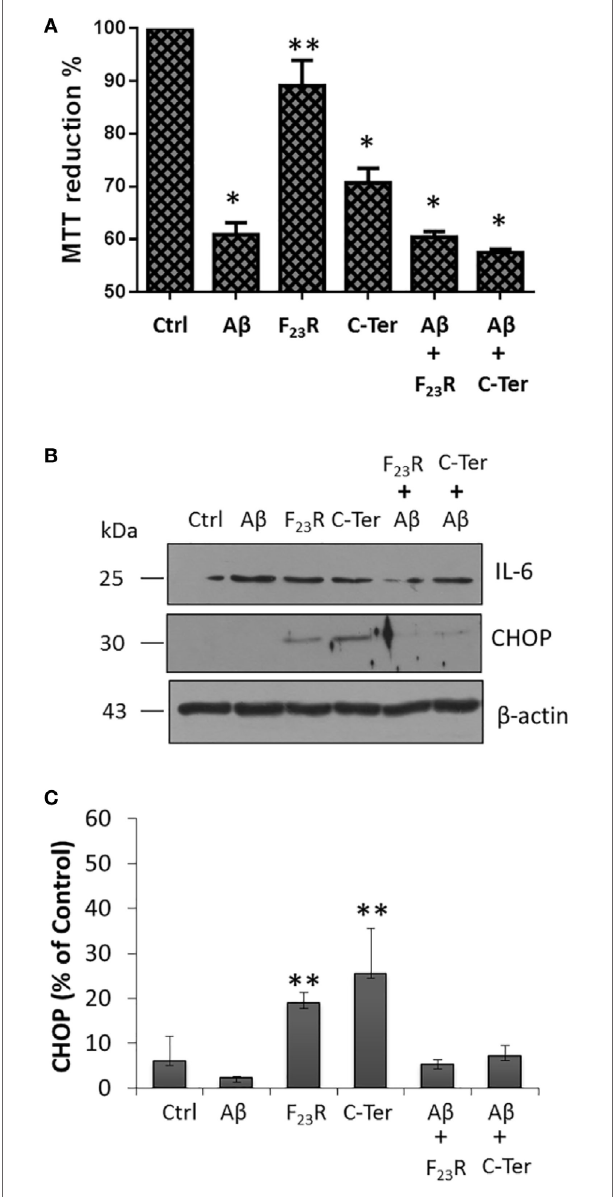
FigUre 7 | Functional modulation of islet amyloid polypeptide sequences in microglia. (a) Responses of cytotoxicity obtained in the microglia model, using the peptide A β as a reference ( n = 6, X ± SD) * p < 0.001, ** p < 0.05. (B) Under the same treatments, CHOP and IL-6 were evaluated, (c) quantification of CHOP expression compared to β -actin